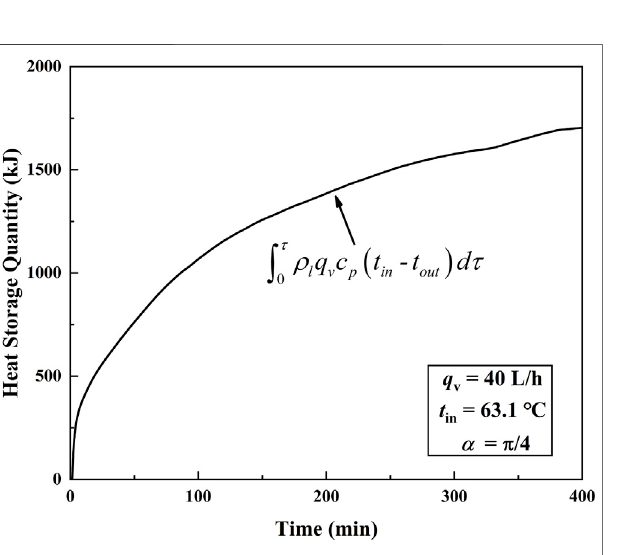
FIGURE 5 | Transient temperature and temperature difference of the inlet and outlet HTF during the melting process for α = π /4.